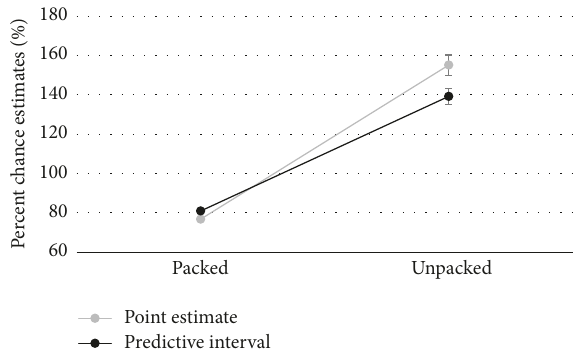
Figure 5: The mean percent chance estimate for events within the boundary values of the predictive interval by point estimate and predictive interval conditions plotted over whether a single question (packed) or four separate questions (unpacked) were asked in Experiment